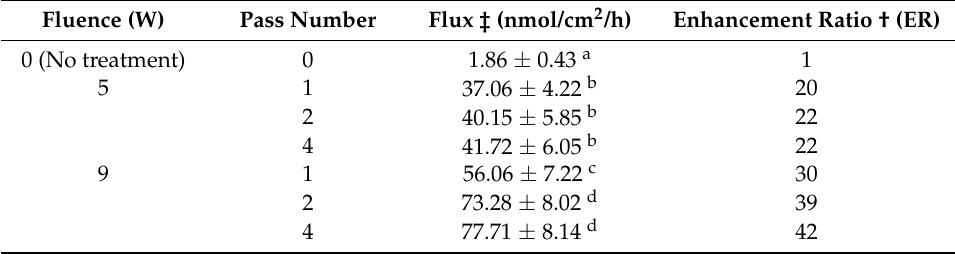
Table 2. MAP-2 normalized fluxes across porcine skin after pretreatment with a fractional CO 2 laser ( n = 8 for each fluency condition).